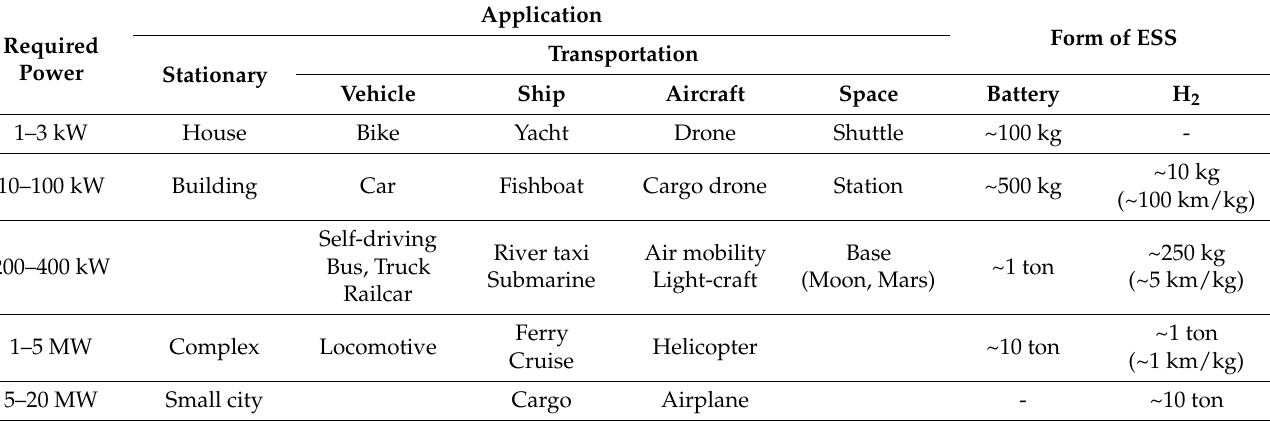
Table 1. Applications and required power and energy storage amounts.